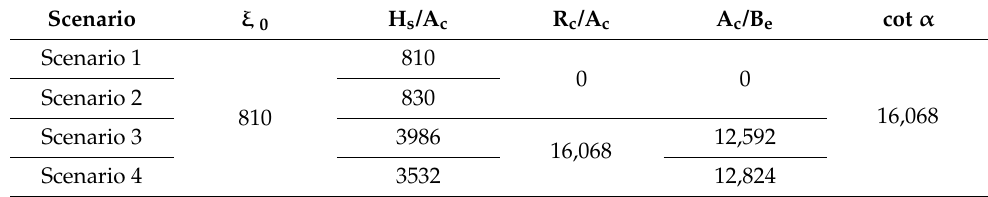
Table 11. Number of cases valid for the formula validity parameters for Pedersen et al. (1996).